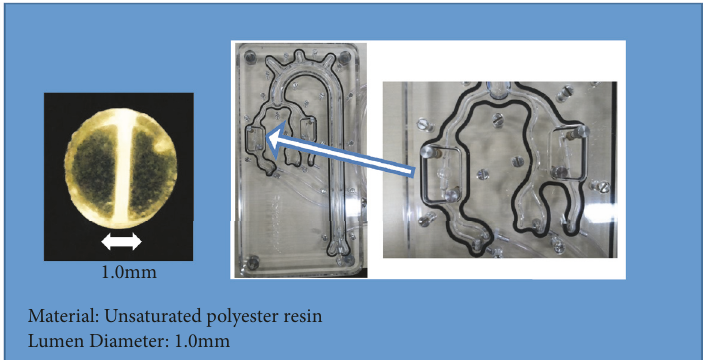
Figure 1: Specifications of In-Vitro Calcified Model. The artificial model was made of unsaturated polyester resins. A calcification model of coronary artery with 1.0 mm inner diameter was used in this